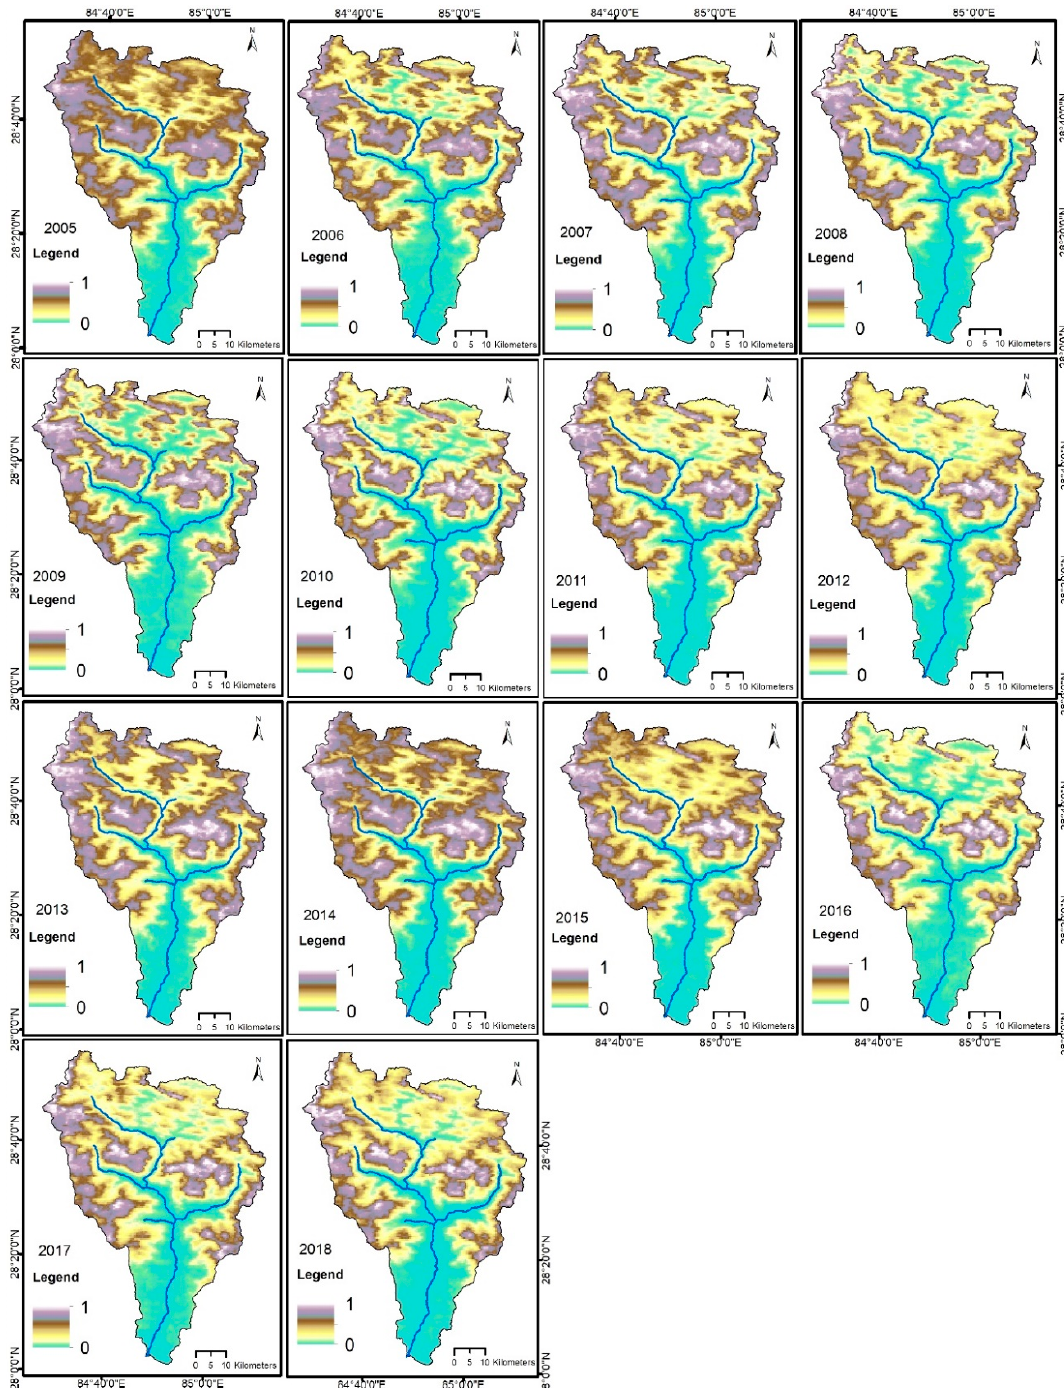
Figure 5. Spatial distribution of snow cover density from 2005 to 2018. The highest range 1 denotes the area with snow cover for 365 days, whereas the least 0 denotes the pixel without snow throughout the study years.